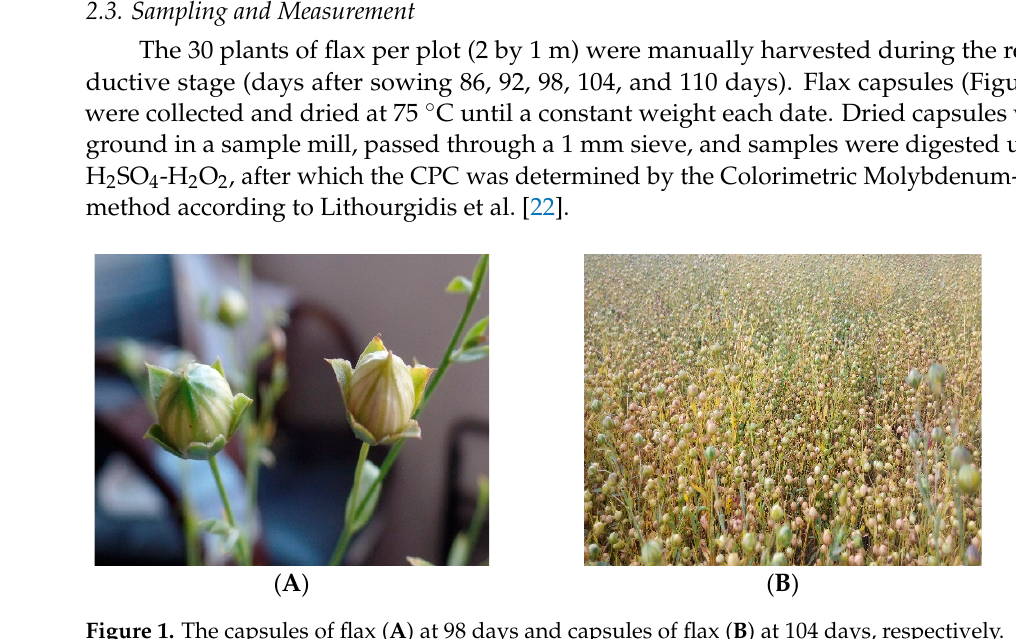
Figure 1. The capsules of flax ( A ) at 98 days and capsules of flax ( B ) at 104 days, respectively. On the harvest date, the crop in each plot was separately harvested using a sickle to determine the seed